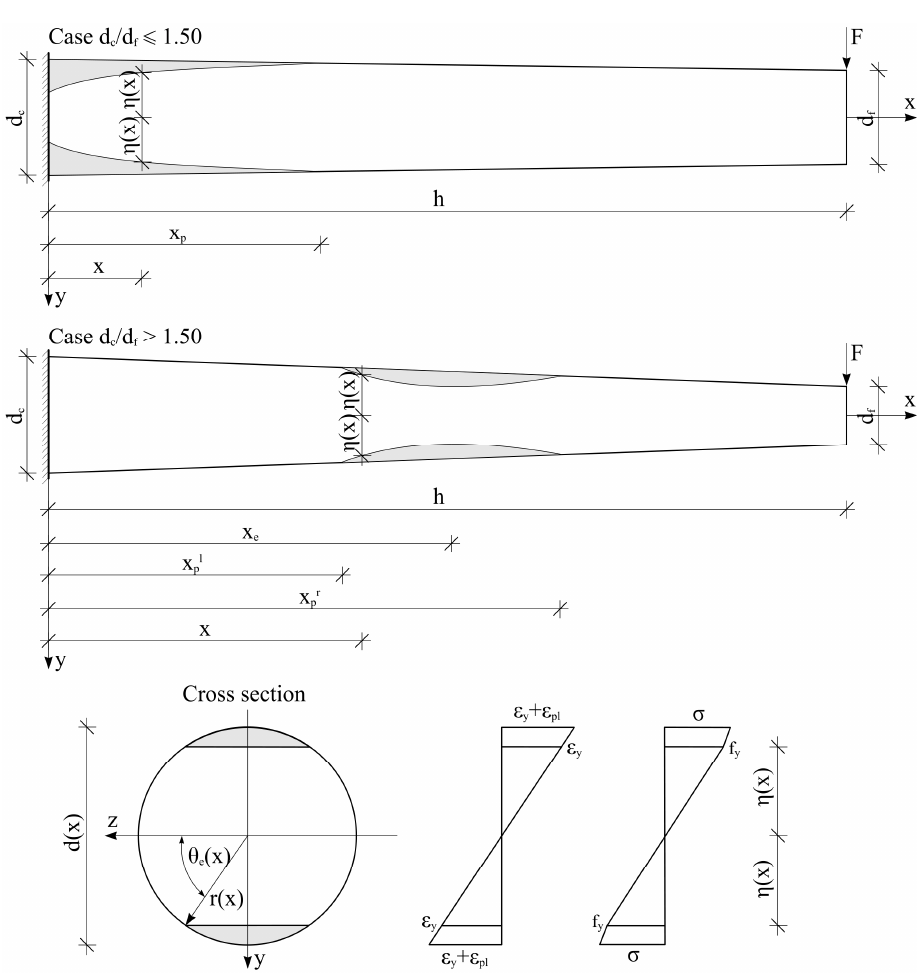
Figure 2. The stress-strain state of the cantilever beam in the plastic regime of the material behavior. The equations of equilibrium in the cross-section must be satisfied at every Equation (25) is of the third degree according to the unknown x p . In cases when the cross-sections diameter ratio is lower than or equal to 1.5, Equation (25) has one real solu-